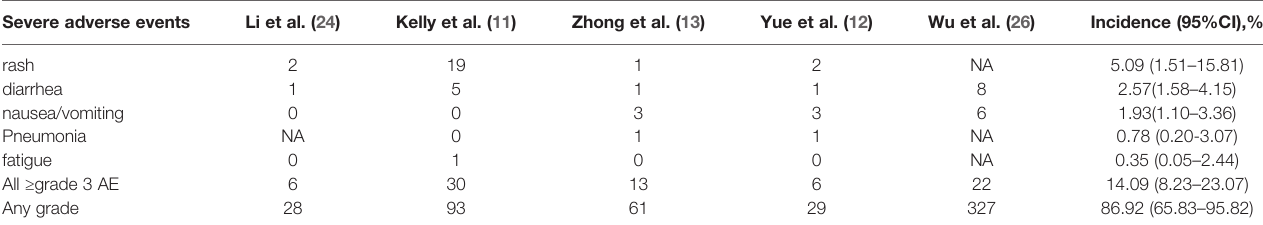
TABLE 2 | Severe Adverse events in EGFR-TKIs treatment